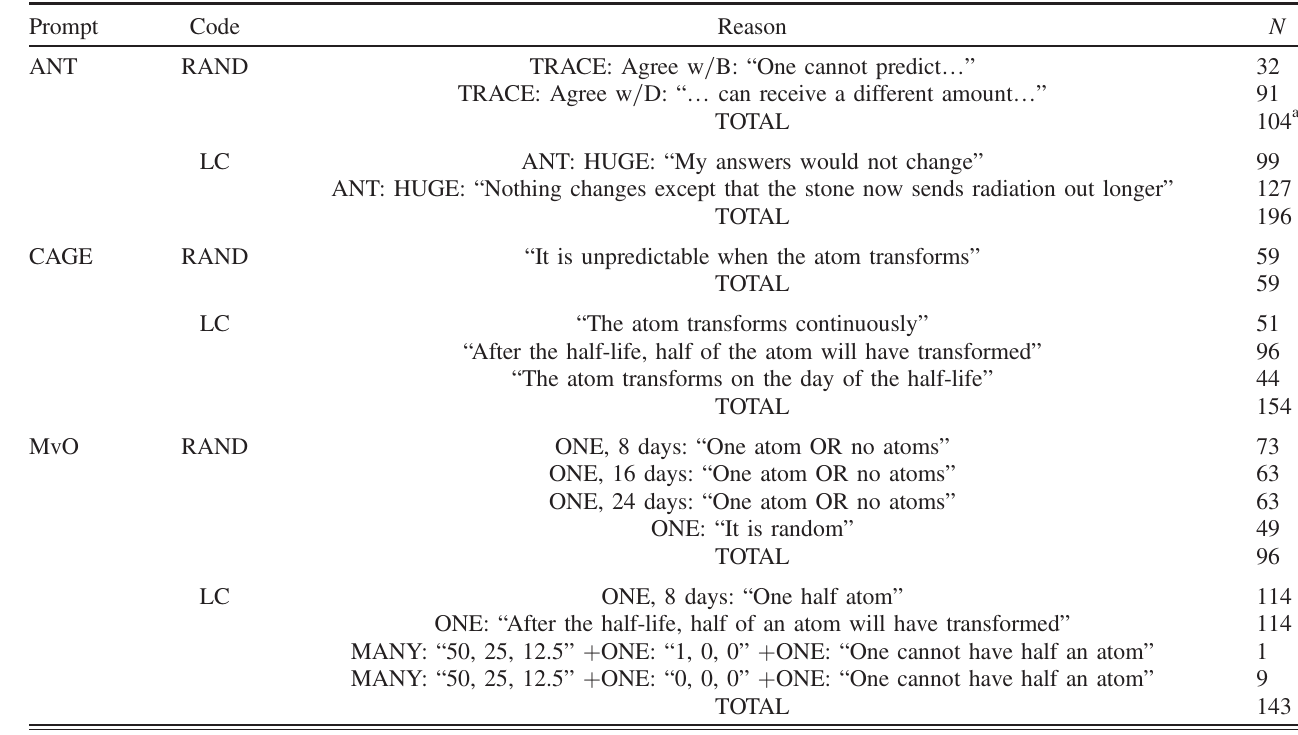
TABLE I. Codes from the three isomorphic prompts, N ¼ 234 . We assigned LC codes to responses that indicated a level confusion and RAND codes to responses that indicated awareness of the randomness of radioactive decay.